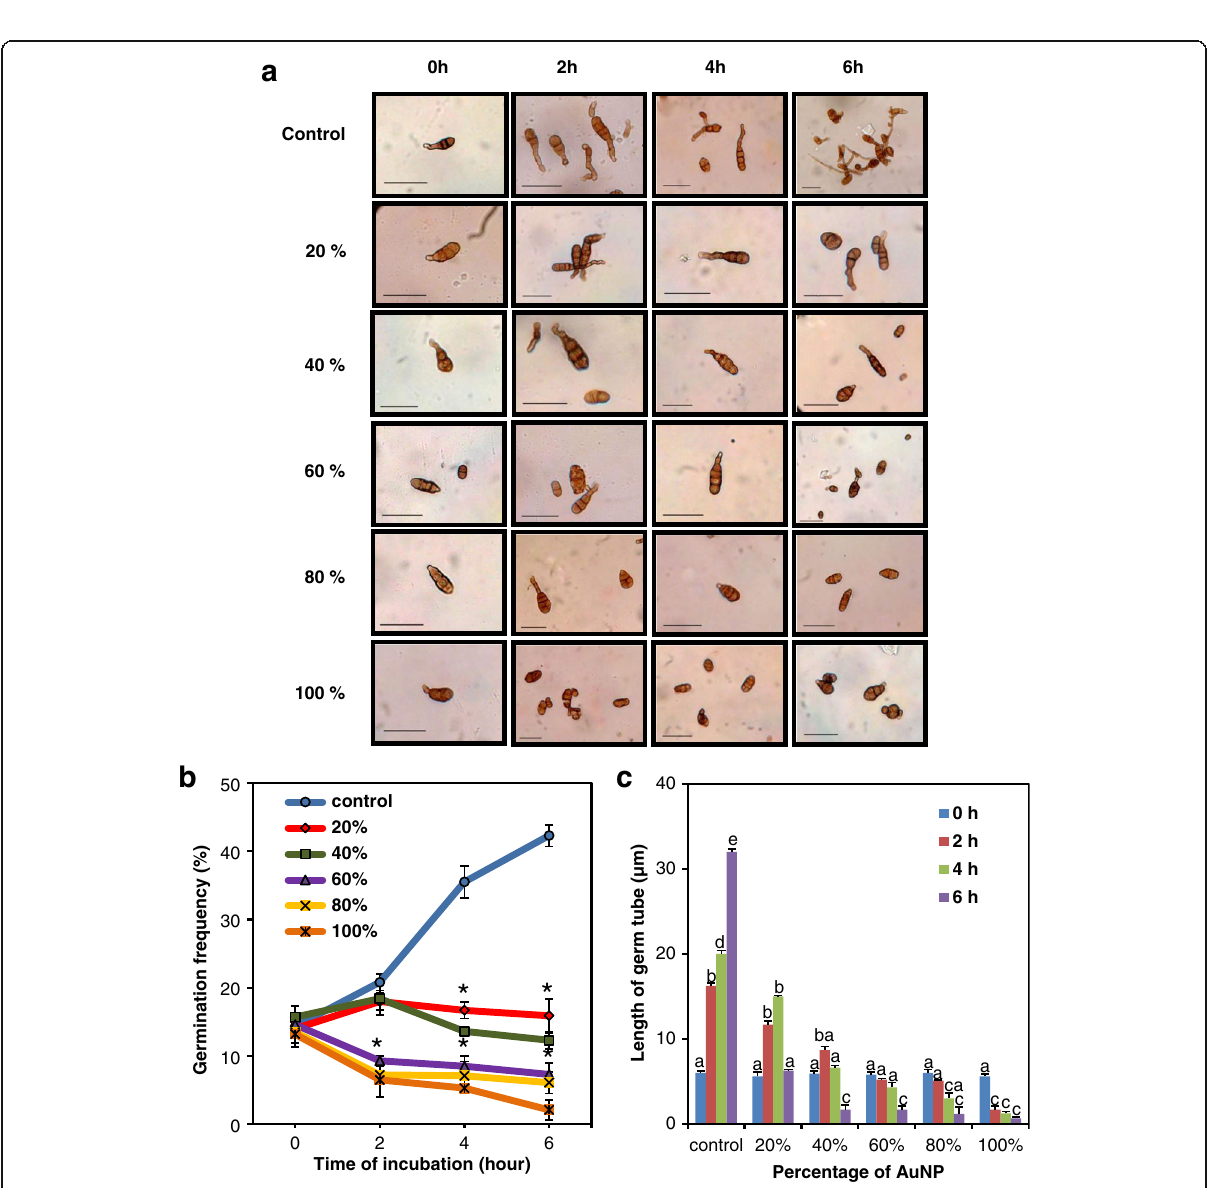
Fig. 7 Effect of the AuNPs on the spore germination of plant pathogenic fungus Alternaria solani ; a Spores after treatment with AuNPs (bar=30 μ m). Rows top to bottom: control spores followed by spores treated with different dilutions of AuNPs (15.56 mg/L stock). Columns left to right: increasing time of incubation with AuNPs showing least germination at 6 h incubation with 100% AuNPs. b Spore germination frequency (%) at different concentrations of AuNPs as a function of time of incubation. Asterisks indicate significant differences to control (Student ’ s t test, P <0.05). c Average germ tube length at different concentrations of AuNPs as a function of time of incubation. Data represents means±SE of three replicates. Different letters indicate statistically significant differences among the samples ( P <0.05, Duncan ’ s multiple range test). Spore germination frequency and the average germ tube length decreased with increasing doses of the AuNPs and increasing incubation